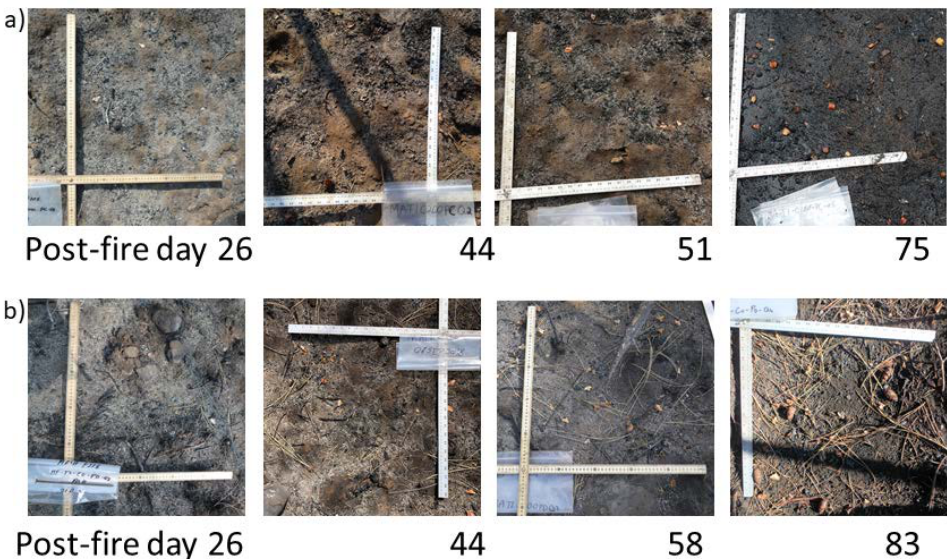
Figure 4. Photo series of two Mesa Fire high-burn severity plots over time ( a ) T1 200 and ( b ) T2 0 randomly selected from the high-severity plots on either end of a 200 m transect. Each photo is cropped to approximately 0.25 m 2 to show greater detail (one quadrant of the full 1 × 1 m plot).